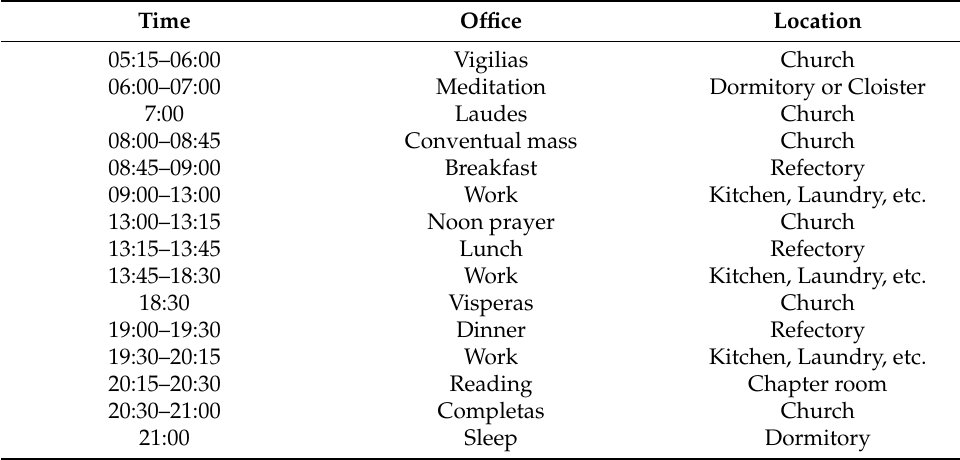
Table 2. Daily Routine for Cistercian Monastic Life (Poblet